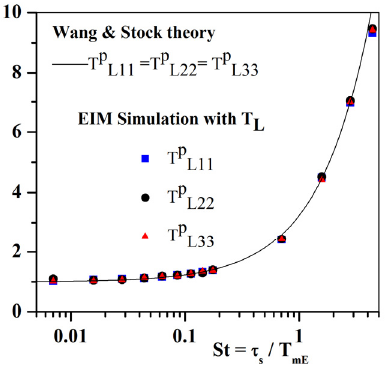
Figure 4. Particle Lagrangian time scale (g = 0).